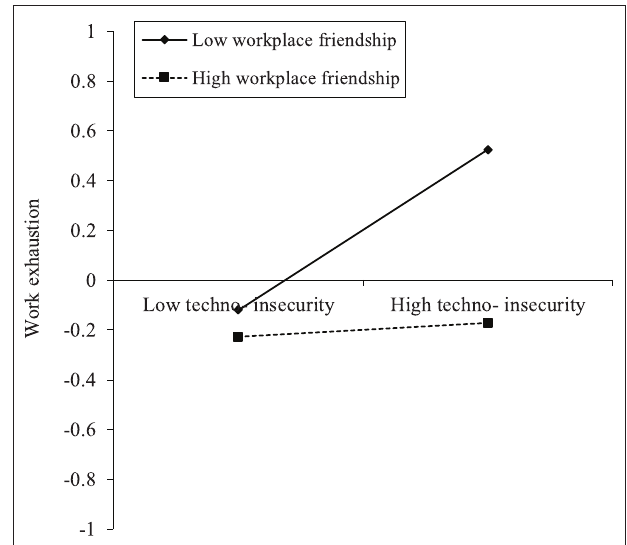
FIGURE 4 | The interaction of techno-invasion and WF on work exhaustion ( N = 254).